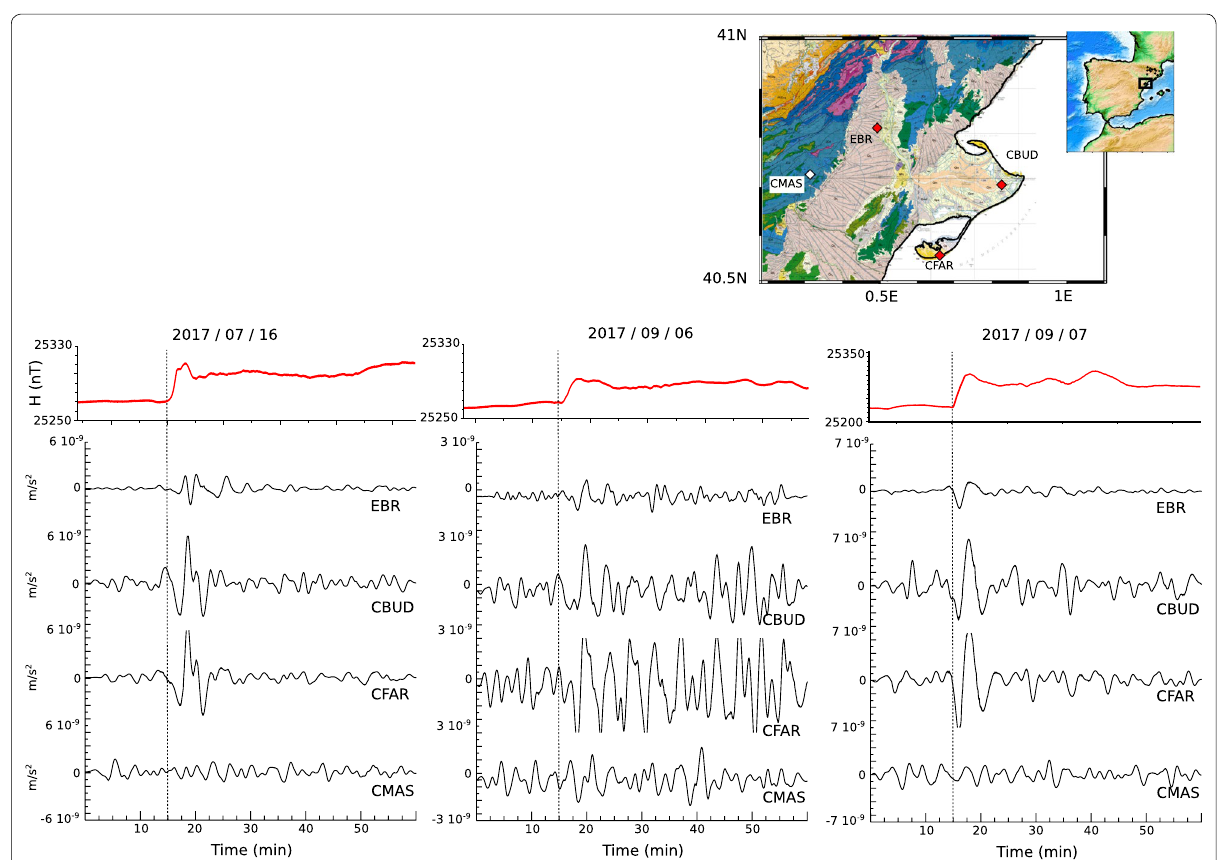
Fig. 6 Seismic records of magnetic events at mid-latitude networks. Seismic acceleration recordings contemporaneous with SSCs’ events at the CA broad-band sites in the Ebro zone, NE Spain. Upper panels show with red lines the magnetograms at EBR magnetic station. Bottom panels show the seismic acceleration represented using a common amplitude. Map onset shows the geological setting of each of the four investigated sites (Mapa geològic de Catalunya 1:100,000; Comarques del Ebre